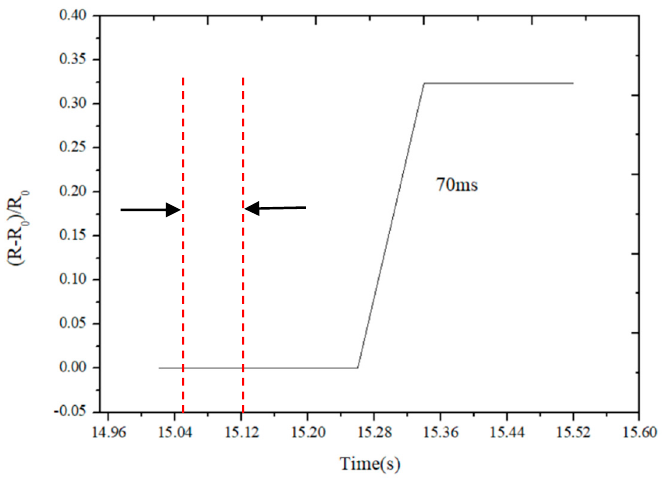
Figure 12. Response time of the flexible sensor.